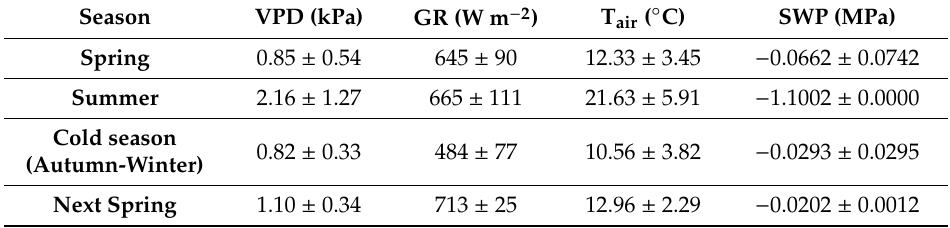
Table 1. Mean vapor pressure deficit (VPD; kPa), mean global radiation (GR; W m − 2 ), mean air temperature (T air ; ◦ C), and soil water potential at 30 cm depth (SWP; MPa) from 06:00 to 14:00 on the days in which the gas measurements were done at the study site. Values are mean ± standard